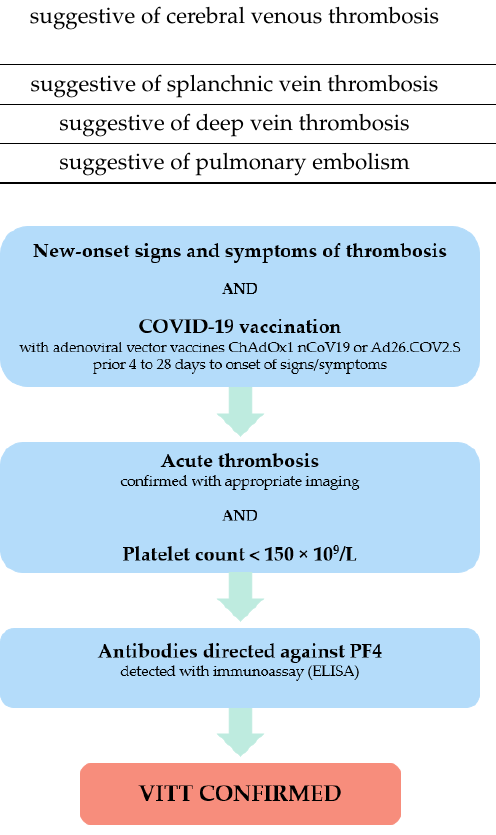
Figure 1. Diagnostic algorithm for vaccine-induced thrombotic thrombocytopenia (modified from ISTH [63]).